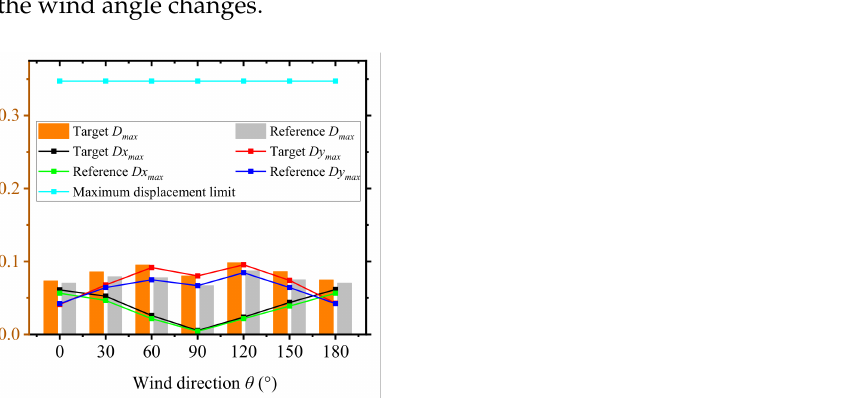
Figure 16. Maximum value of displacement of the building model along the vertices of the body